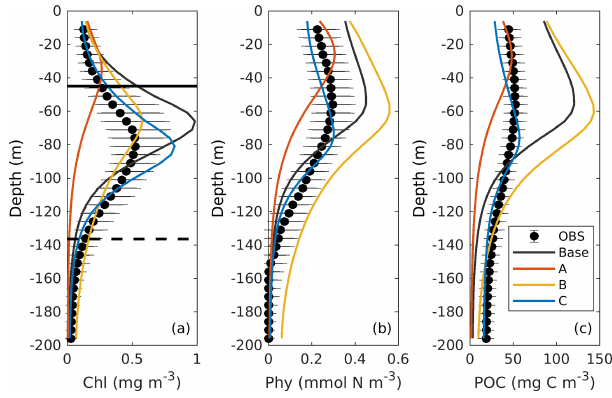
Figure 4. Observed (black dots with error bars) and simulated (col- ored lines) vertical profiles of chlorophyll, phytoplankton, and POC. Black errors represent the interquartile range of observations. The solid and dashed black lines in (a) represent the median values of mixed layer depth from July and